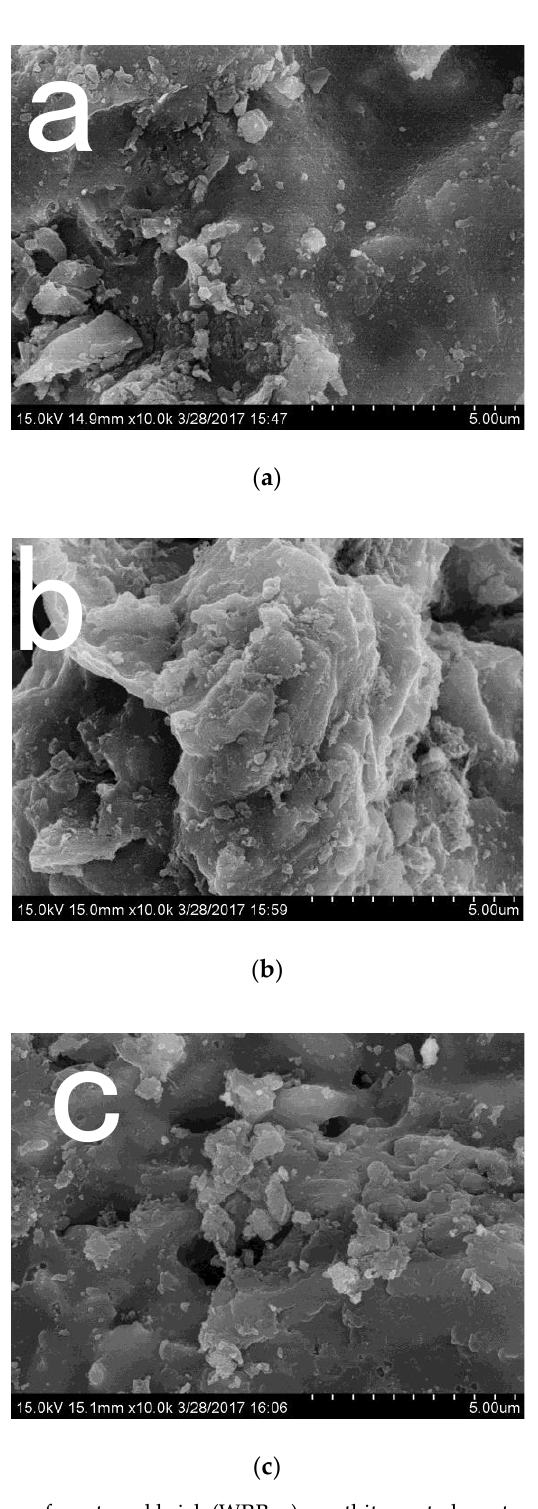
Figure 1. The SEM images of waste red brick (WRB; a ), goethite coated waste res brick (GWRB; b ), and hematite coated waste res brick (HWRB; c ). Table 2. The chemical analysis, specific surface area and amount of coated iron on the surface of adsorbents.